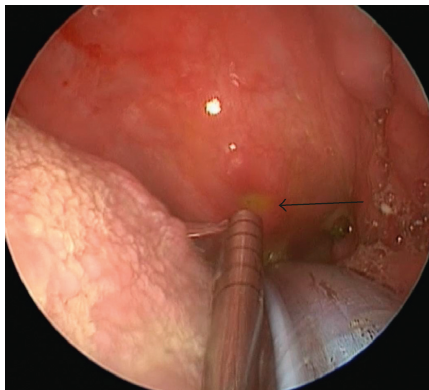
Figure 2: Endoscopic identification of fluorescein-dyed CSF in the oropharynx.